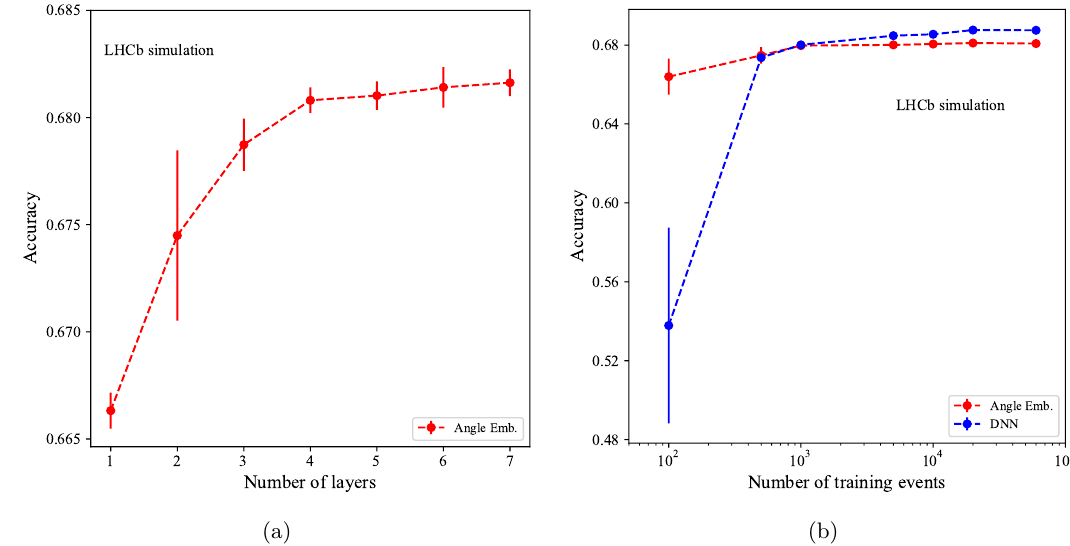
Figure 9. (a) Accuracy of the Angle Embedding structure on the muon dataset versus the number of layers. (b) Accuracy of the (red) Angle Embedding structure and (blue) DNN on the muon dataset versus the number of training